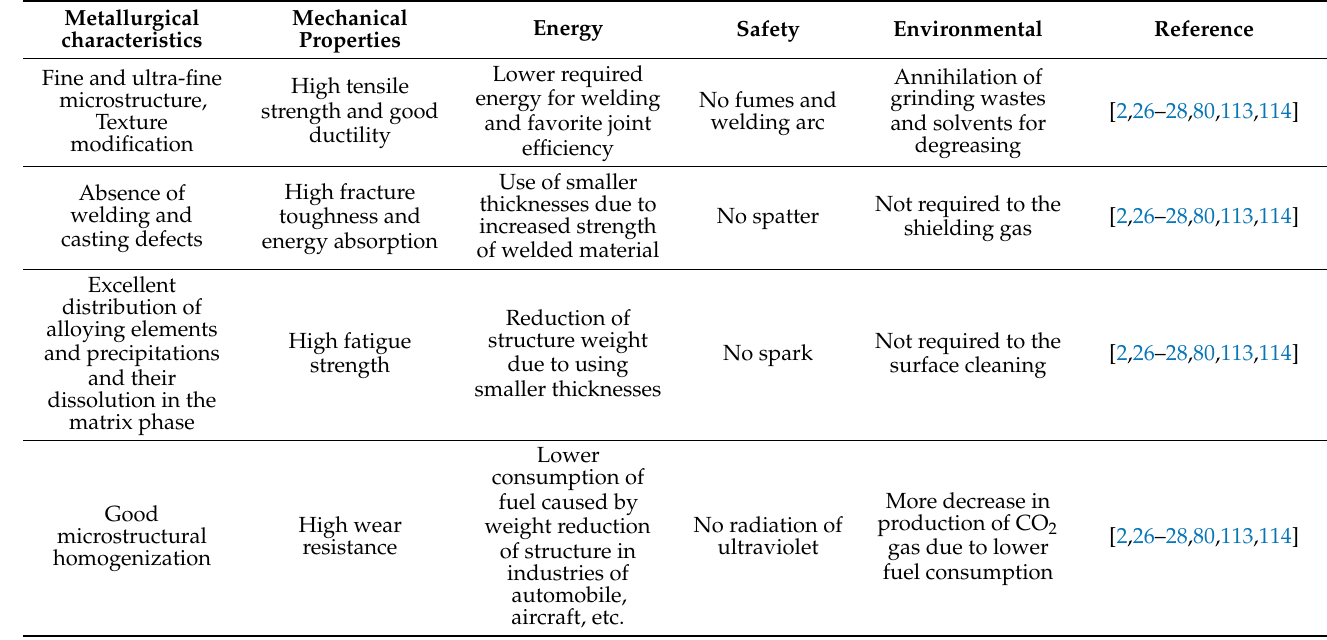
Table 4. Advantages of the FSW/FSP